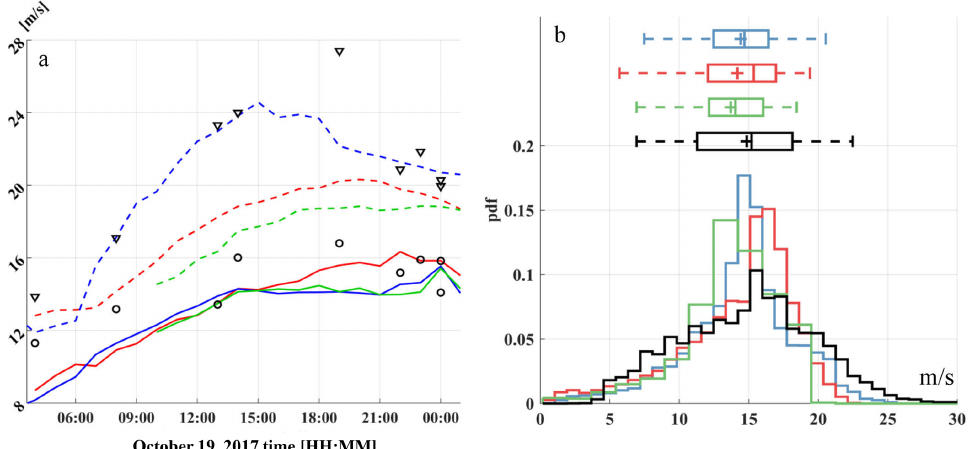
Figure 7. The surface wind speed (m/s) in the mature PL 3 derived from the satellite measurements and ERA5 (red), MERRA-2 (green) and the CFSv2 (blue) data sets for the median (solid lines) and extreme (dotted lines) winds ( a ); probability density function and box plots of the ERA5 (red), MERRA-2 (green), CFSv2 (blue) and satellite-based (black) wind speed within a 300-km radius of the PL center ( b ). Black circles and triangles on ( a )—the median and extreme values of the satellite wind, respectively. The whiskers indicate the 5th–95th percentile range; the median and average are marked in the boxes with vertical bars and plus signs,